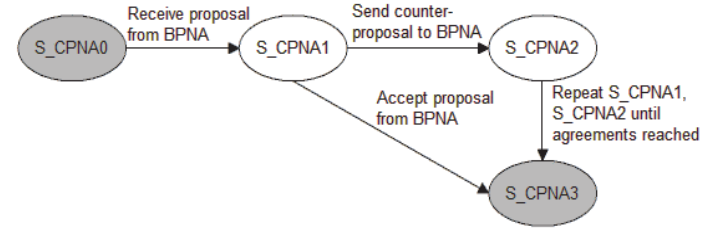
Fig. 7. State transition diagram of the